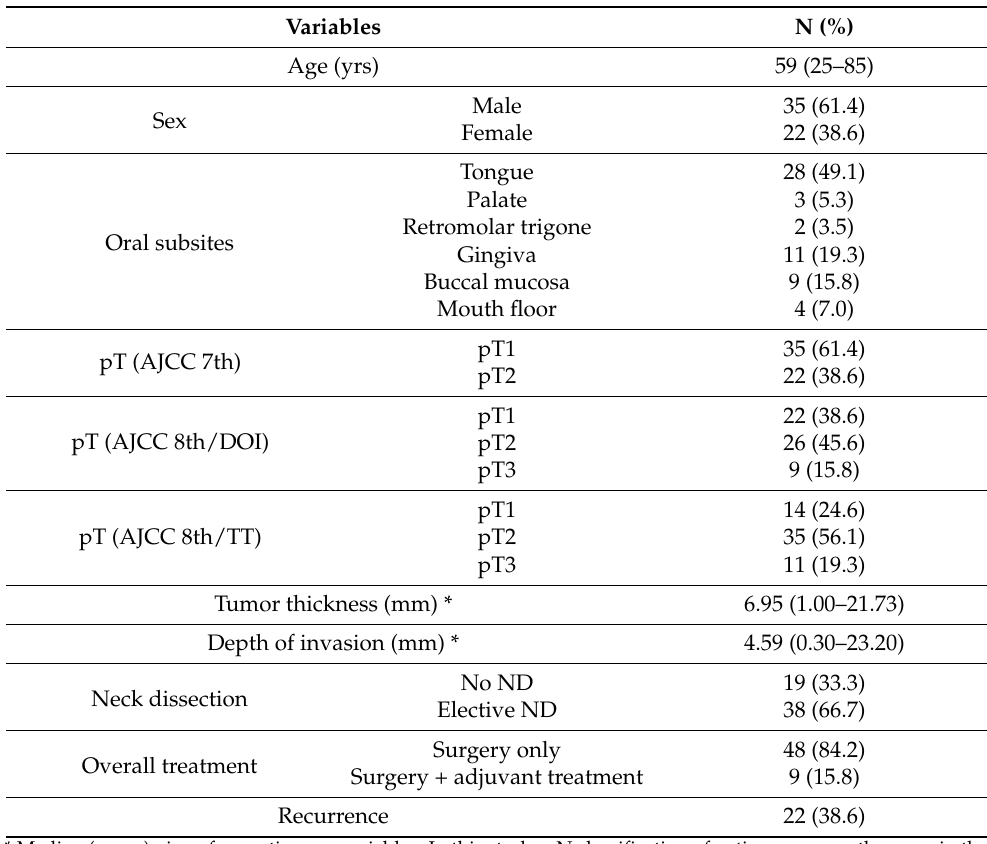
Table 1. Clinicopathological characteristics of the 57 patients in the study.